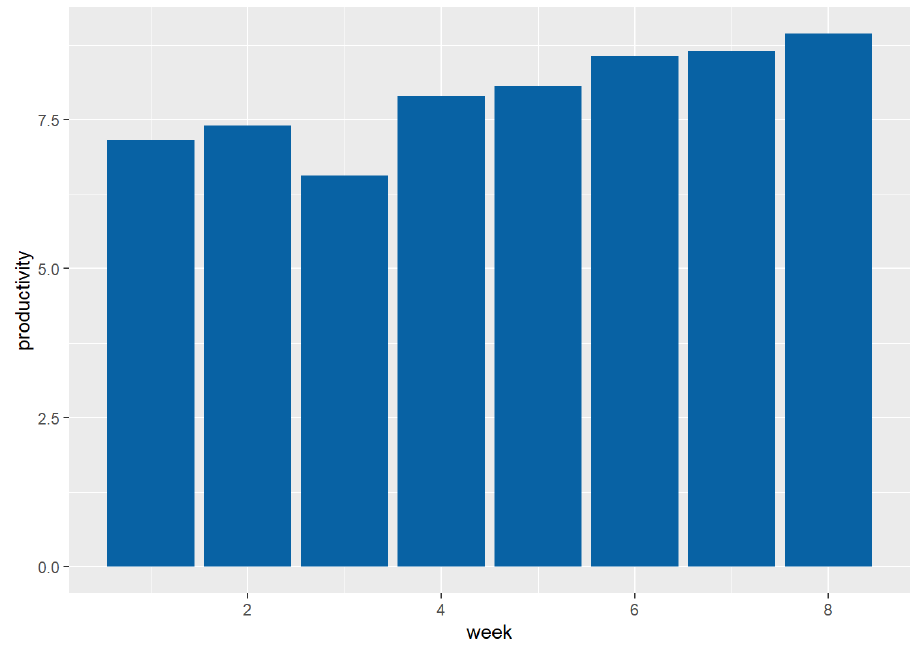
Figure 12. Team 2